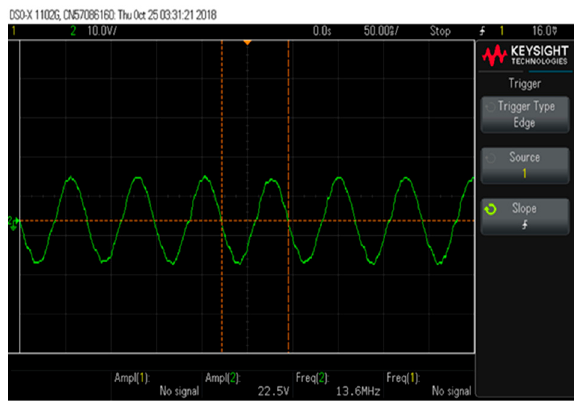
Figure 18. waveform in the transmitter coil ( V T